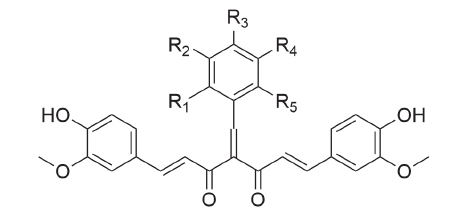
FIGURE 2 - Position of substituents on the benzaldehyde group attached to curcumin via Knoevenagel